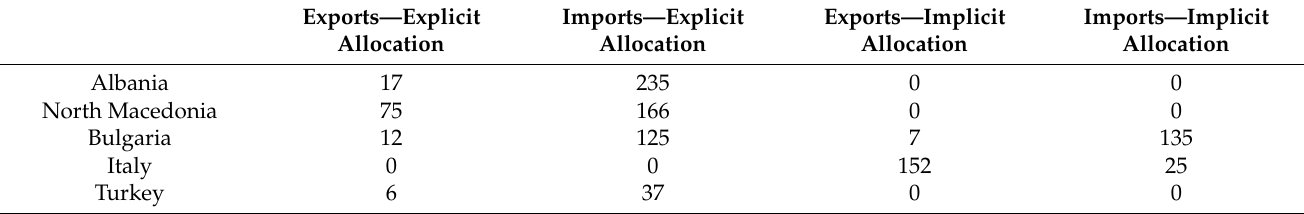
Table 3. Imports/Exports at Day-Ahead Market, May 2021 (GWh), Source: Hellenic Energy Exchange and Authors’ estimations. Exports—Explicit Allocation